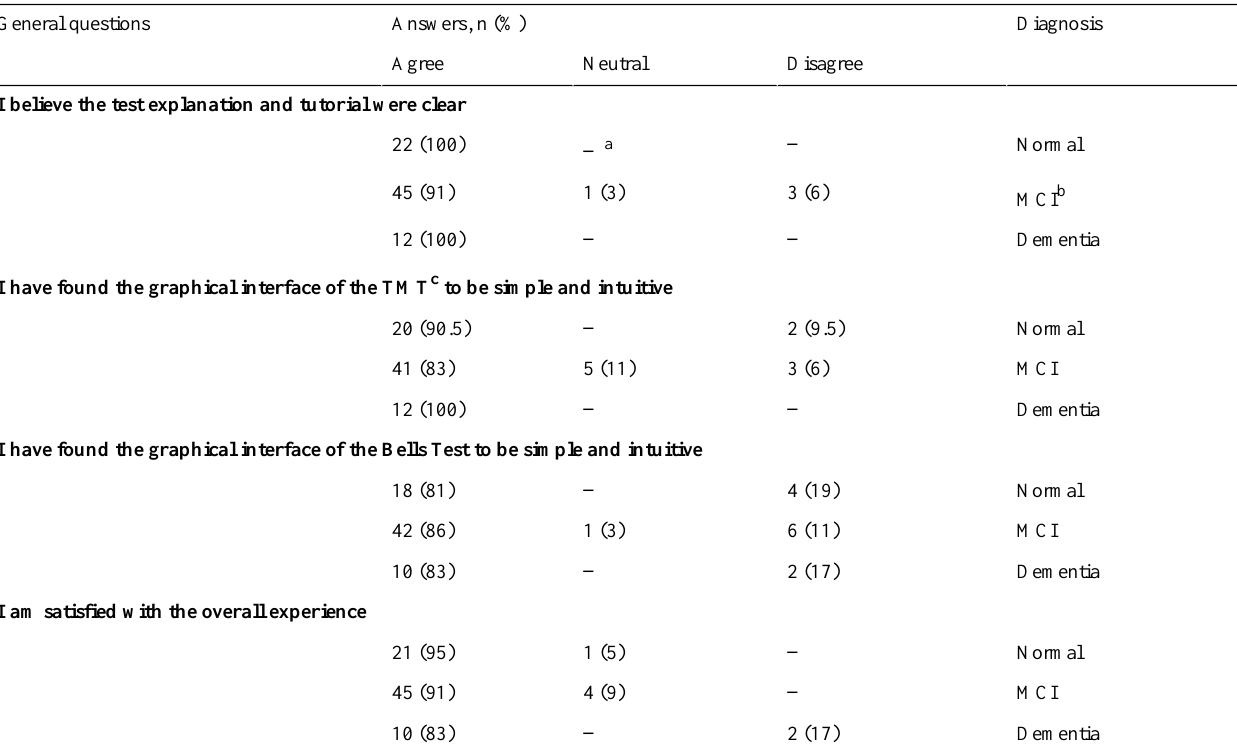
Table 2. System acceptance results from questions rated on a 3-point Likert